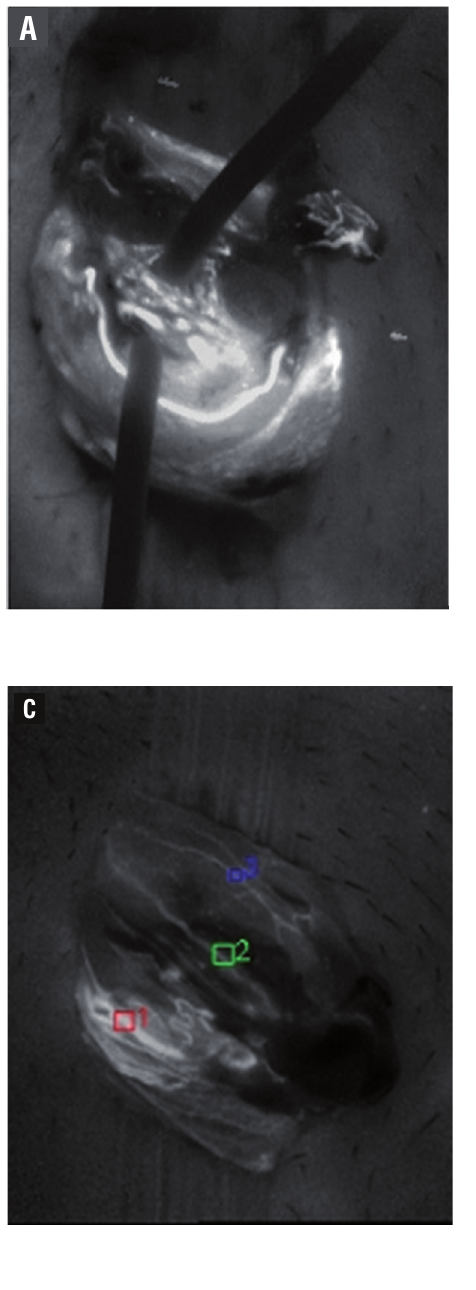
Figure 2 - Built-in fluorescence modules of the operating microscope provided analysis of the vascular dynamics. A) Infrared 800 module demonstrates the relative intensity of indocyanine green signal. B) Flow 800 module illustrates the sequences the flow dynamics into a visual map. C) Interpretation of specific area on the angiographic image can be marked and D) Flow dynamic of each region can be illustrated in the form of